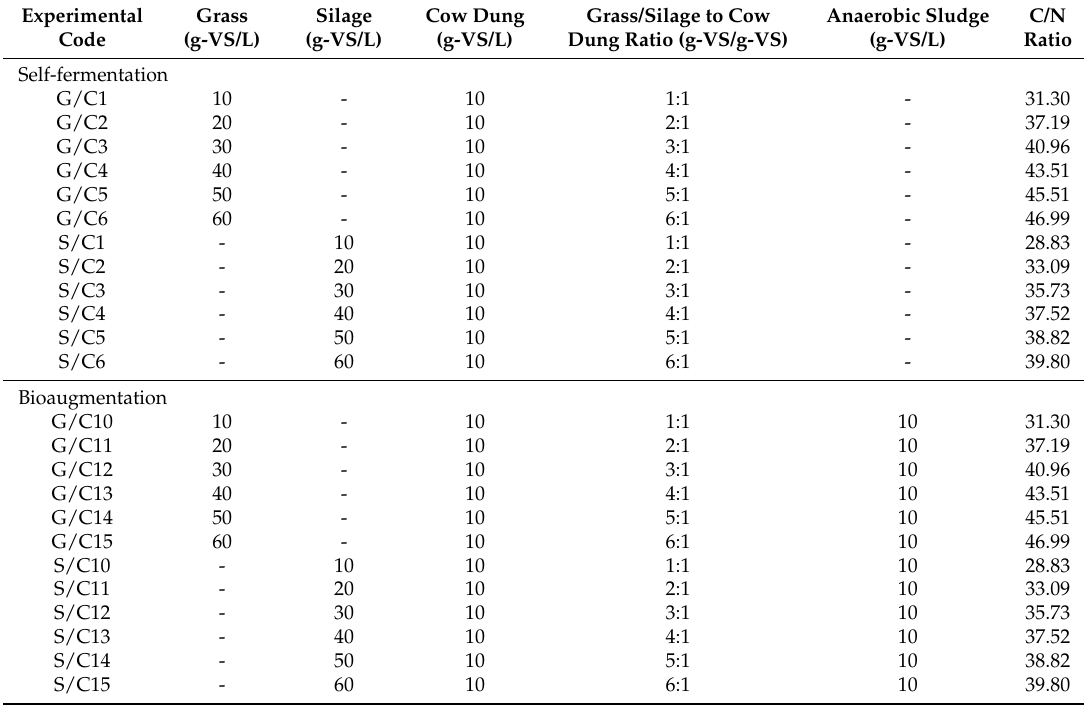
Table 1. Experimental set up for methane production from a co-digestion of grass with cow dung and silage with cow dung bioaugmended with anaerobic sludge and a self-fermentation (without anaerobic sludge), using 10 g-VS/L cow dung concentration.